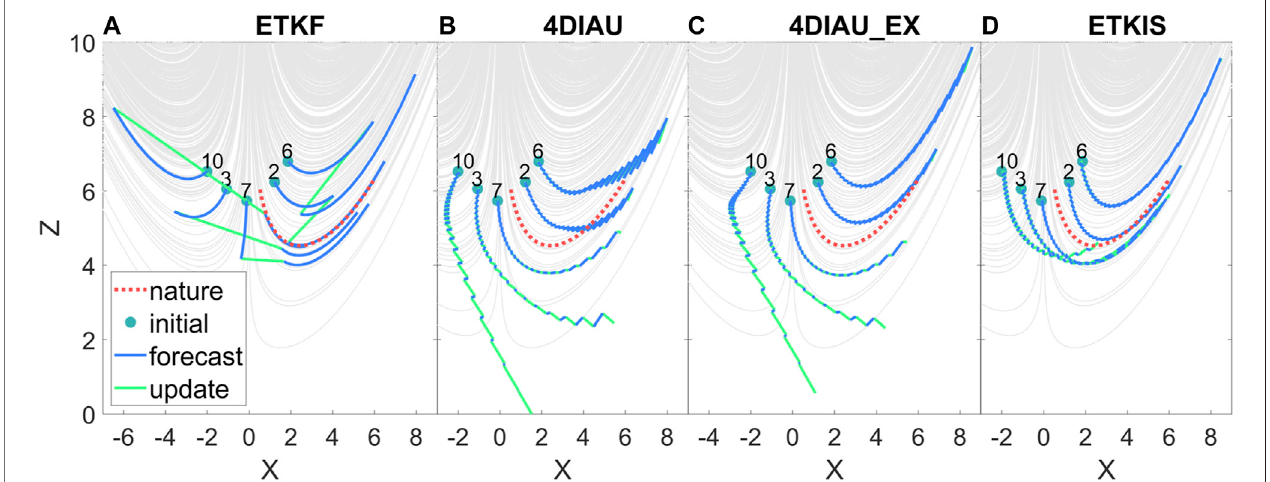
FIGURE 5 | The trajectories of ensemble forecast (blue) and nature (red) during the 316th DA cycle with the L63 model with different DA schemes: (A) ETKF, (B) 4DIAU (C) 4DIAU_EXand (D) ETKIS.Thegreendotistheinitialconditionoftheensemblemember andthegreenlineistheadjustmentoftheDAschemefrom theof fl ine experiment. The number corresponds to the ensemble member number. The gray line is a trajectory from long-term free integration to exhibit the nonlinear behavior of the L63 model. Only fi ve ensemble members are selected for clear illustration.